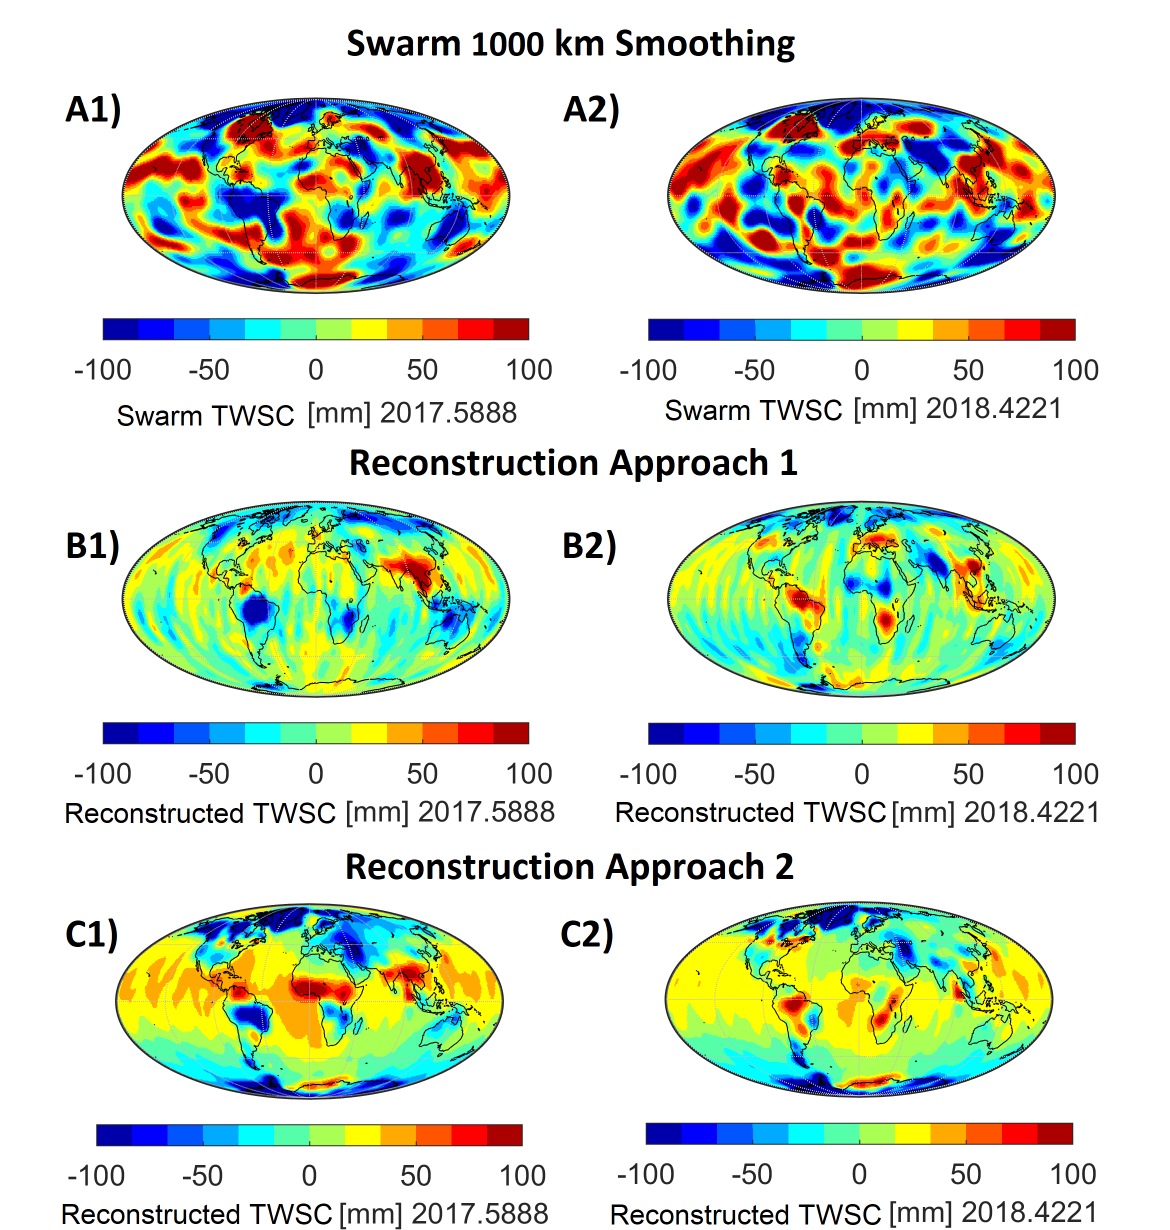
Figure 3. Results of the two reconstruction techniques for the period that only Swarm fields exist; ( A1 , A2 ) show the original Swarm fields in 2017.5888 (July 2017) and 2018.4221 (May 2018), respectively; ( B1 , B2 ) indicate the reconstruction results of Approach 1; ( C1 , C2 ) represent those of Approach 2. To make sure that the reconstruction approach works properly, when the GRACE-FO data are available, we extended the time of investigation to end of 2019. Figure 4 compares Swarm (Figure 3A1,A2), the reconstruction of Approach 2 (Figure 3B1,B2), and GRACE-FO (Figure 3C1,C2) that correspond to 2019.2890 (March 2019) and 2019.6246 (July 2019), respectively. Here, we only show the hydrological signals (i.e., oceans ans polar regions are masked). A visual comparison indicates that the reconstructed fields (Figure 3B1,B2) are very close to those of GRACE-FO (in Figure 3C1,C2), compared to those of Swarm (Figure 3A1,A2). An average correlation coefficient of 0.89 are found between the reconstructions and GRACE-FO during